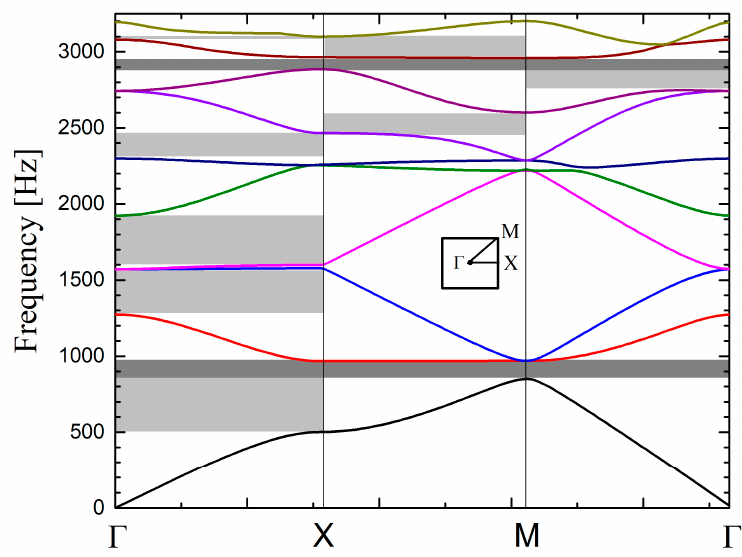
Figure 4. Acoustic bands of a square lattice of rigid cylinders embedded in air. Dark stripes indicate complete band gaps and light grey stripes define the partial gaps. The inset plots the reciprocal lattice together with high symmetry points that define the irreducible